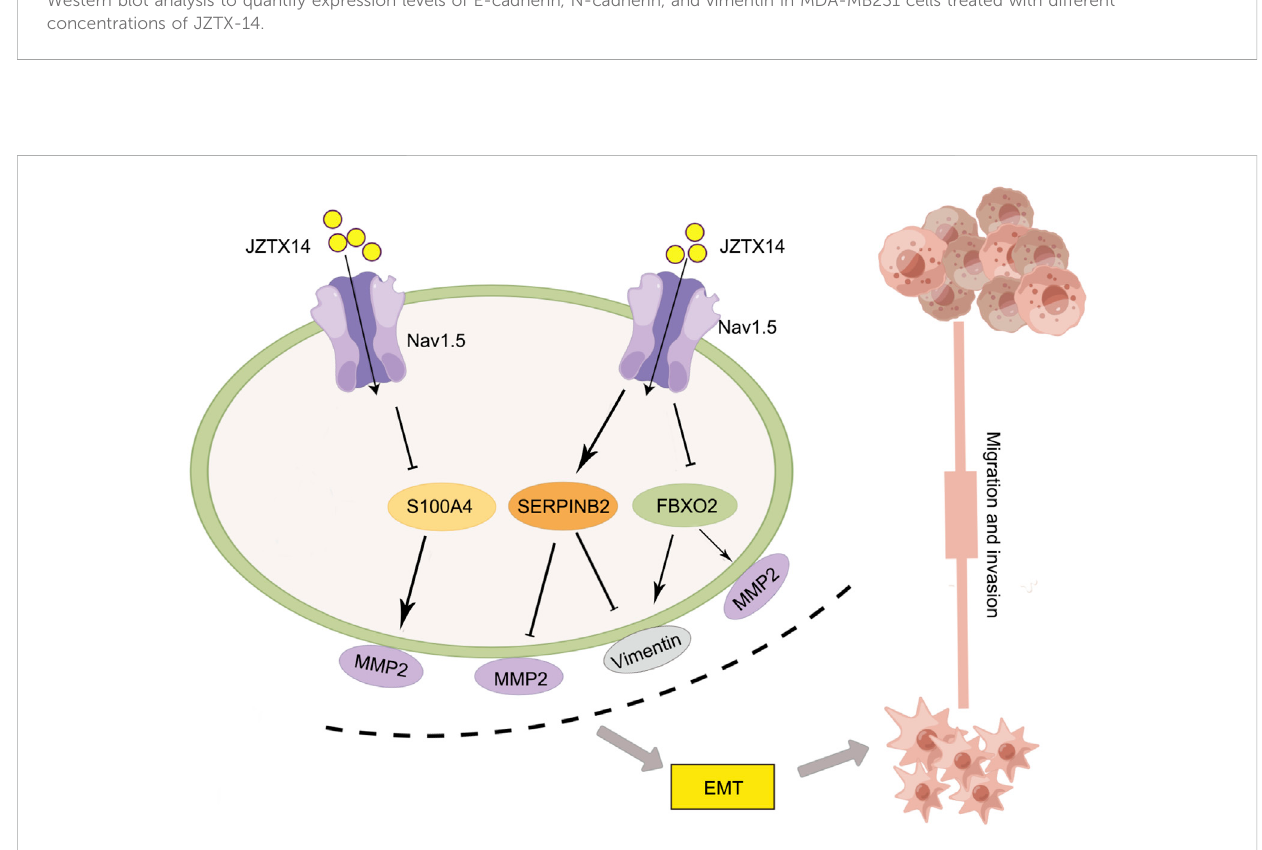
FIGURE 9 Schematic diagram of the molecular mechanism by which JZTX-14 inhibits the migration and invasion of MDA-MB-231 cells. The fi gure is drawn with the help of